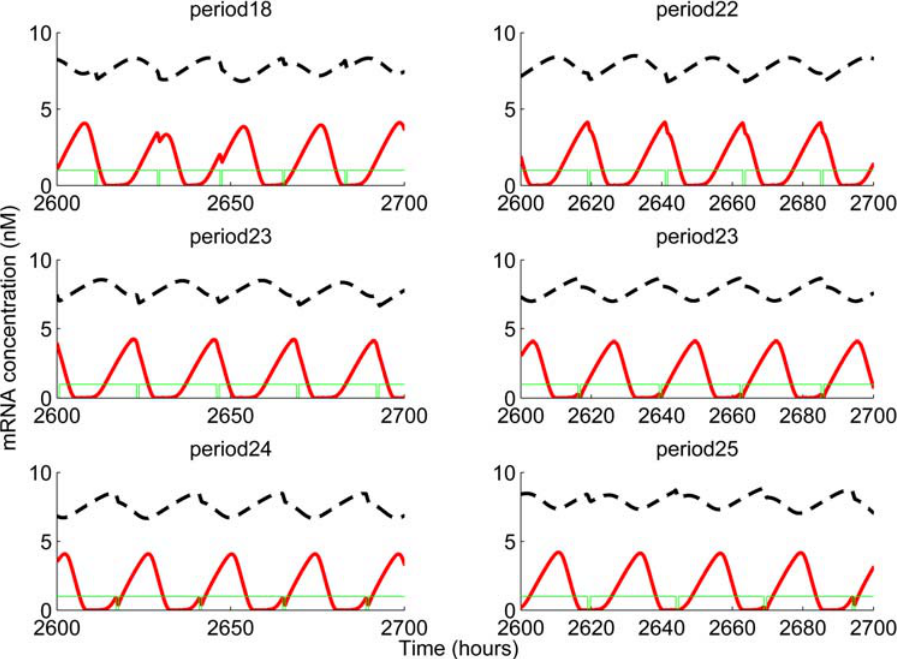
Figure 4. Steady state circadian phases of cell cycle M-phase for periods of 22, 23 and 24 hours. Simulations are performed as described in Figure 1 and Figure 2. Dynamics of different state variables are directly plotted.